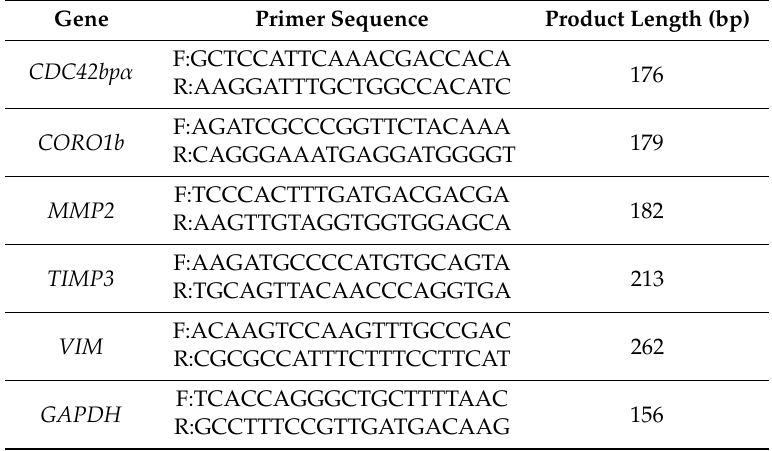
Table 1. Sequences of real-time PCR primers and length of the obtained